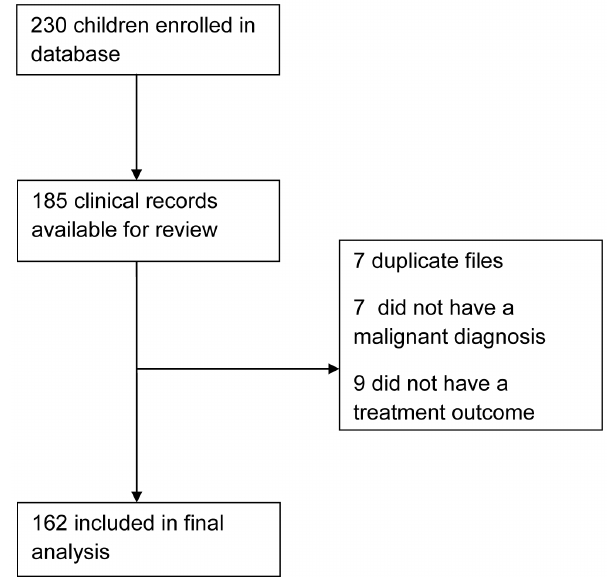
Figure 2. Consort Diagram.